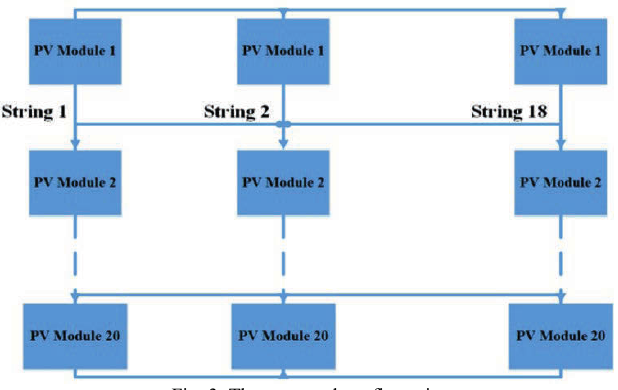
Fig. 3. The proposed